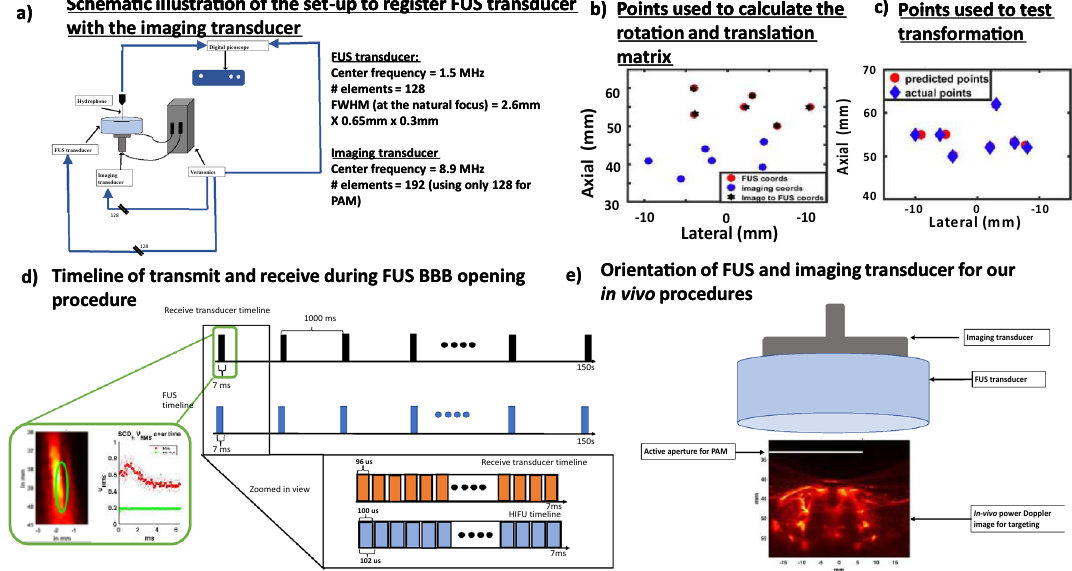
Figure 1. Registration of FUS transducer and FUS therapy. ( a ) Schematic diagram to record B-Mode hydrophone positions. Hydrophone positions were used to register the FUS transducer to the imaging transducer. ( b ) A total of 6 B-Mode images were collected to calculate rotation and translation matrix using Eq. 1, yielding a precise rigid transformation between the image and therapy space. ( c ) 7 target points were collected to verify registration and calculate target registration error (0.6 ± 0.3 mm). ( d ) The receive transducer recorded 96 µs for each 100 µs FUS pulse, which repeated at 9.8 kHz for a total duration of 7.0 ms during in vitro and in vivo applications. The in vitro application lasted 10 s and in vivo lasted 150 s. The receive signals were used to make passive acoustic maps and were used to calculate cavitation doses inside green box. ( e ) FUS transducer and imaging transducer were placed on top of rat skull. Imaging transducer was first used to collect power Doppler image at 50 Hz. This power Doppler image was then used for guiding FUS transducer. White band on power Doppler image shows active aperture of imaging transducer that was used to record receive echoes during FUS